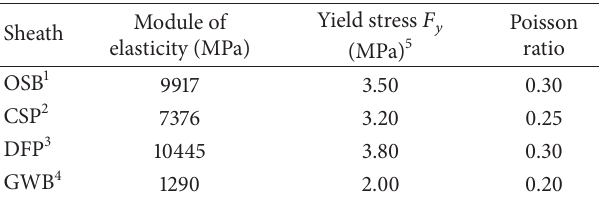
Table 2: Material properties of